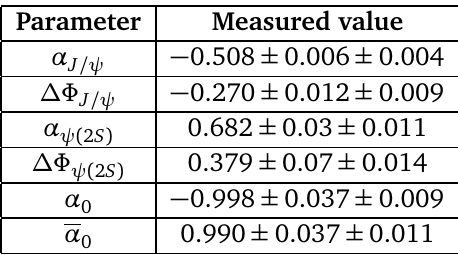
Figure 5: Oscillating behavior of neutron effective FF [ 9 ] . Table 1: BESIII results [ 10 ]